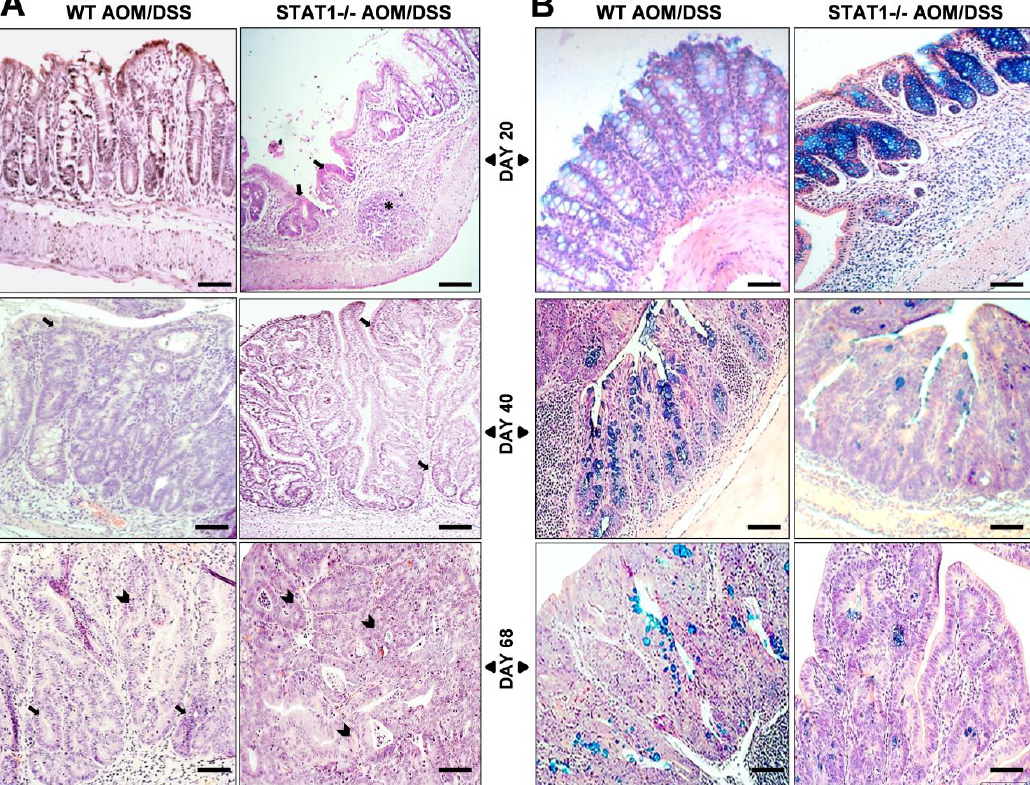
Figure 3. STAT1 deficient mice have more advanced dysplasia and goblet cell decreases compared to WT colons. The colons were removed, fixed, and stained with H&E ( A ) or Alcian blue ( B ) at the indicated time intervals. ( C ) The histological score shown in each group of mice was determined as mentioned in M&M and is expressed as mean ± SD. Scale bars: 50 µm. * indicate hyperplastic lymphoid node, arrow indicate numerous hyperplastic gland polyps and arrowhead atypical epithelial cells with dysplastic nucleus and mitotic figures. A remarkable decrease of goblet cells was observed at Day 40 in STAT1 − / − AOM/DSS. Demonstrative photographs and data are representative of two independent experiments with at least three mice per group per day of the analysis. Statistically significant differences between two groups were judged by Student ’ s t -tests. * p ≤ 0.05. 2.3. The Absence of STAT1 Does Not Alter the Early Expression of Markers for Tumorigenesis β -Catenin and cyclooxygenase-2 enzyme (COX-2) play essential roles in colon carcinogenesis. Increased expression of both could be used as a marker of tumor progression and poor prognosis [29]. A significant increase in COX-2 expression was observed in WT AOM/DSS and STAT1 − / − AOM/DSS mice compared with control mice in immunohistochemical staining (Figure 4A,B). However, the percentage of COX-2 + cells in the colon tissue was significantly lower in STAT1 − / − AOM/DSS mice compared with WT AOM/DSS animals at 40 and 68 days after AOM administration (Figure 4A,B). As expected, strongly positive cytoplasmic or nuclear β -catenin staining was observed